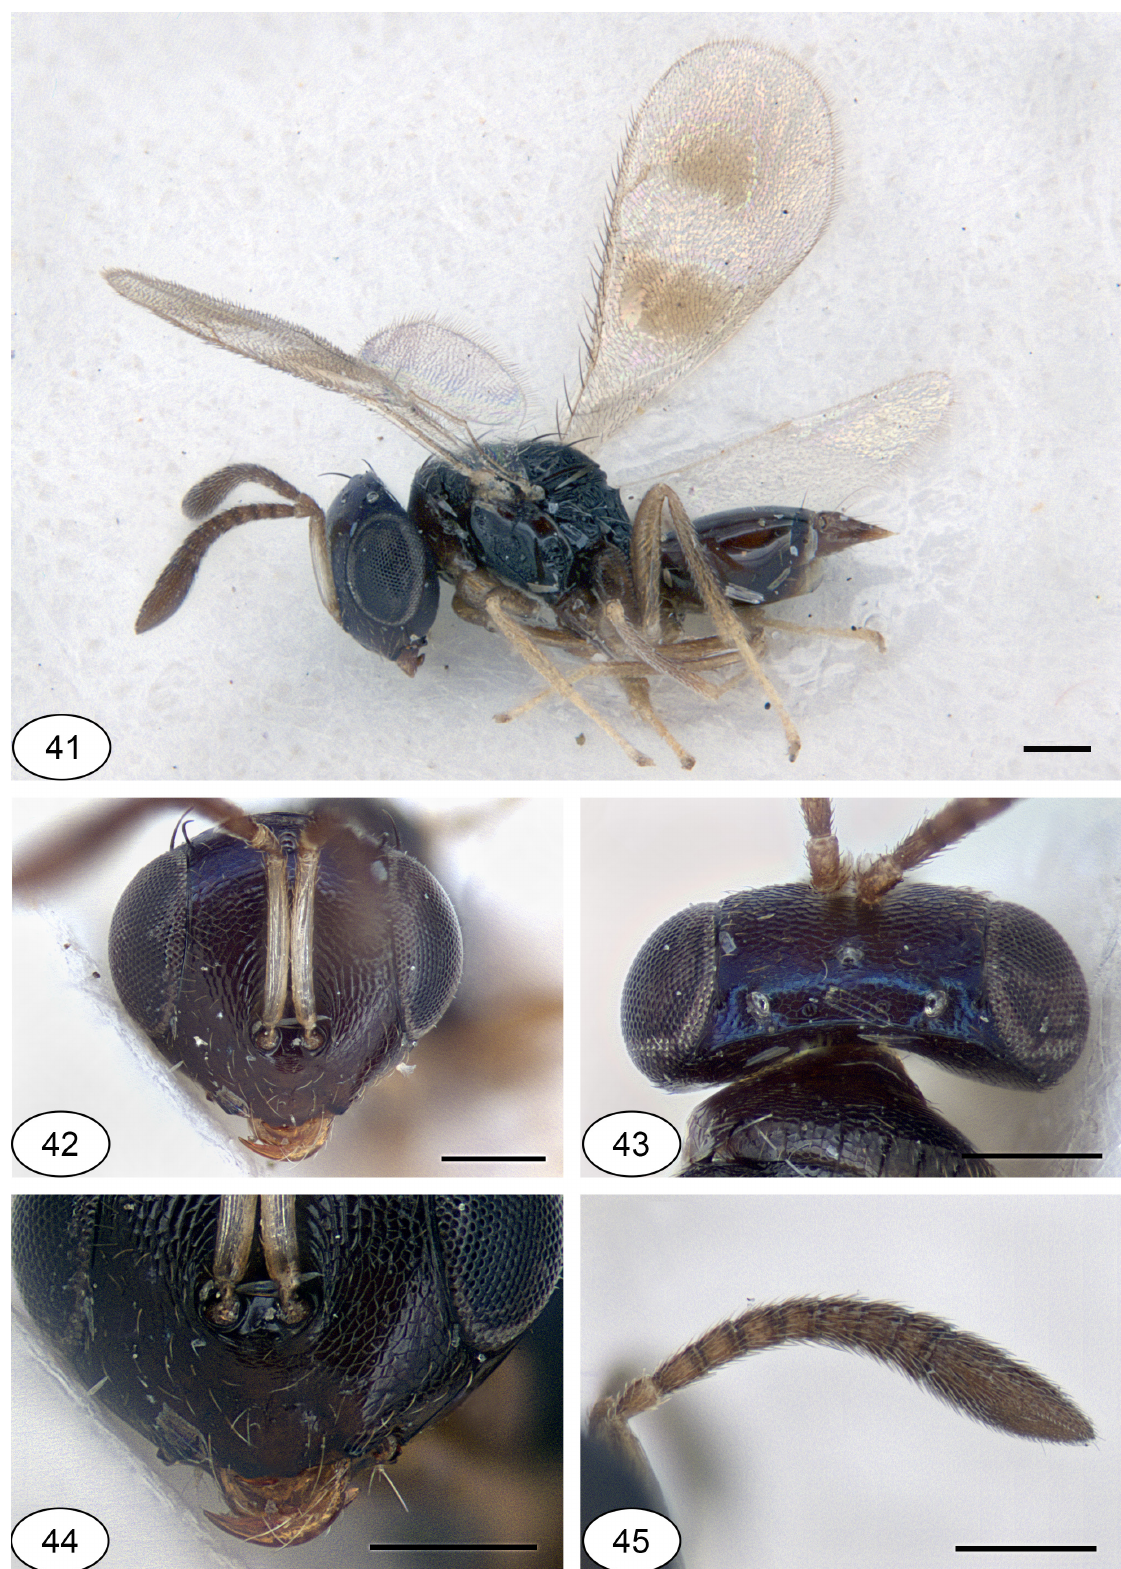
Figs 41–45. Netomocera cyanocephala sp. nov., holotype, ♀. 41 . Habitus, lateral view. 42 . Head, frontal view. 43 . Head, dorsal view. 44 . Lower face. 45 . Antenna. Scale bars: 0.2